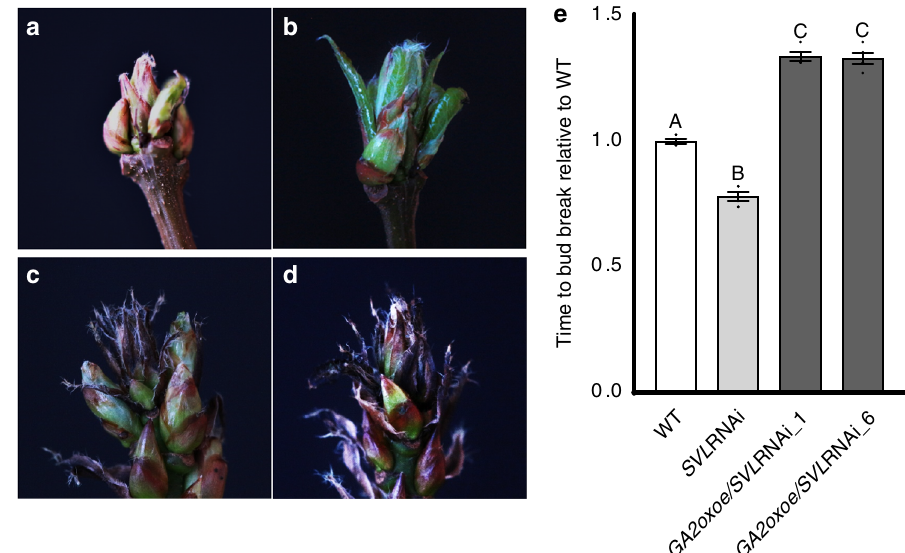
Fig. 5 Overexpression of GA2 oxidase represses early bud break in SVL RNAi lines. a – d Bud break is earlier in a WT and b SVL RNAi plants than in c , d two independent lines overexpressing GA2 oxidase in a SVL RNAi background, designated GA2oxoe / SVL RNAi_1 and 6, respectively. e Time to bud break relative to WT controls for SVL RNAi plants, and lines overexpressing GA2 oxidase in a SVL RNAi background. Average time taken to bud break ± SEM, with respect to WT considered as 1, is shown with data from 10 plants from each line. Different letters A – C over the bars indicate signi fi cant differences at P < 0.001.